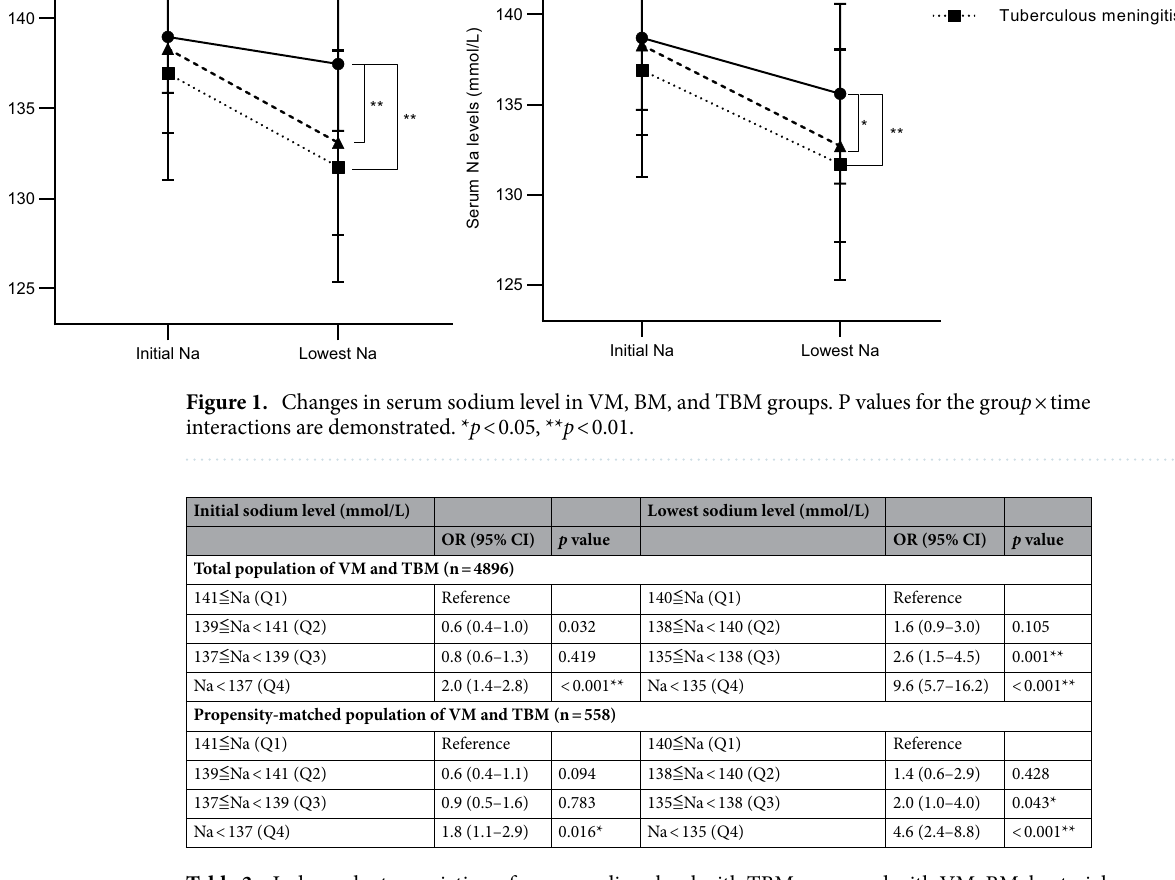
Table 3. Independent association of serum sodium level with TBM compared with VM. BM, bacterial meningitis; OR, odds ratio; TBM, tuberculous meningitis; VM, viral meningitis. Serum sodium levels in the first quartile (Q1), second quartile (Q2), third quartile (Q3), and fourth quartile (Q4). Analyses were performed with multiple logistic regression tests, controlling for age, sex, cerebrospinal fluid (CSF) white blood cell count, CSF glucose, and CSF protein. Propensity was matched for age, sex, cerebrospinal fluid (CSF) white blood cell count, CSF glucose, and CSF protein. * p < 0.05, ** p <